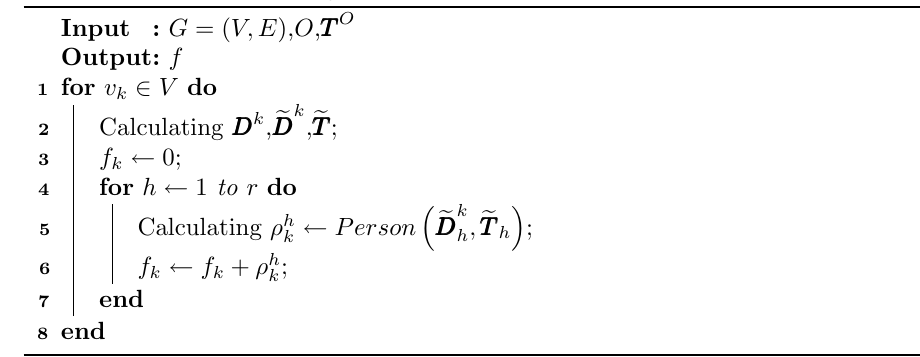
Algorithm 1: Pearson algorithm for multi-source location in complex